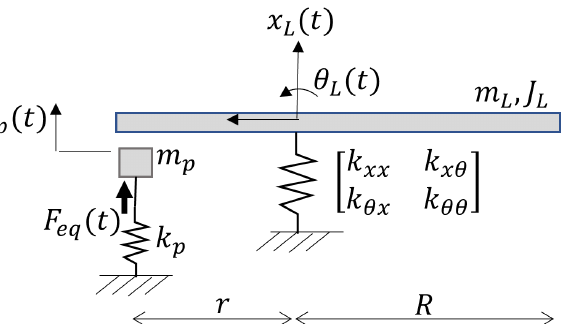
Figure 1. Schematic model of transducer impacting elastic amplification mechanisms.